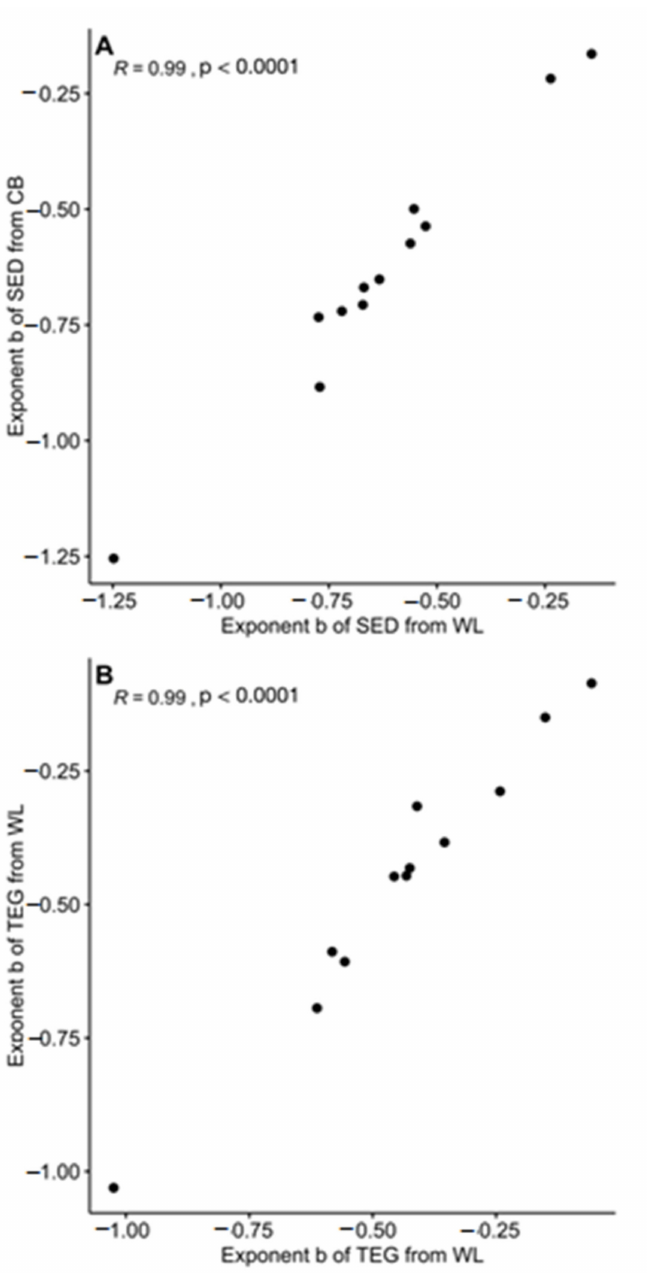
Figure 3. Scatter plot and Spearman rank correlation between estimates of “b” from the whole lake (WL) and central basin (CB) based on single-echo detections (SEDs) ( A ) and tracked-echo groups (TEGs) ( B